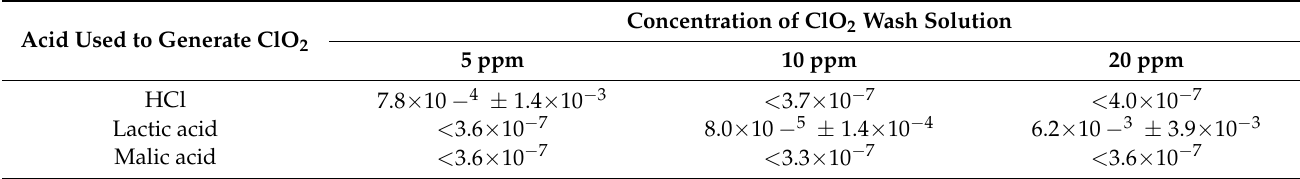
Table 5. ClO 2 residue (mg/kg) on papaya surface after being washed with ClO 2 *. Acid Used to Generate ClO